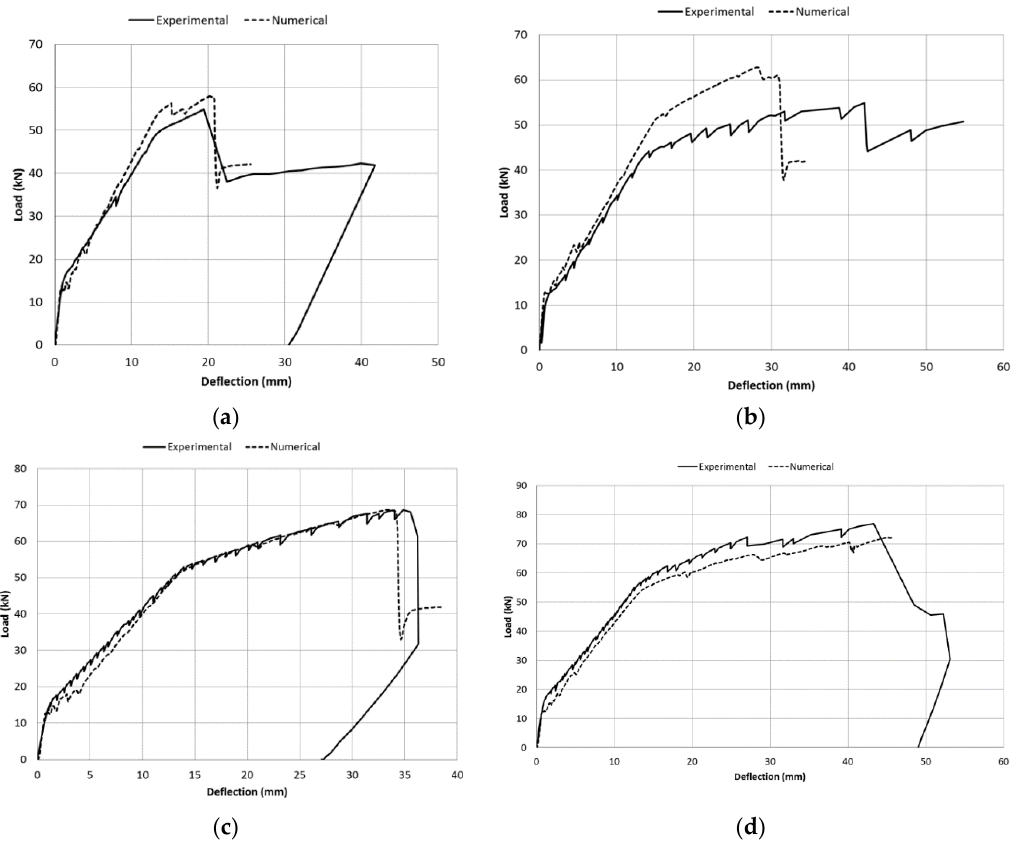
Figure 8. Experimental/Numerical load-midspan deflection curve: ( a ) Beam G1; ( b ) Beam G1-U; ( c ) Beam P1; ( d ) Beam P1-U. Table 5. Experimental/Numerical load and strain values. UHTSS refers to Ultra High Tensile Steel